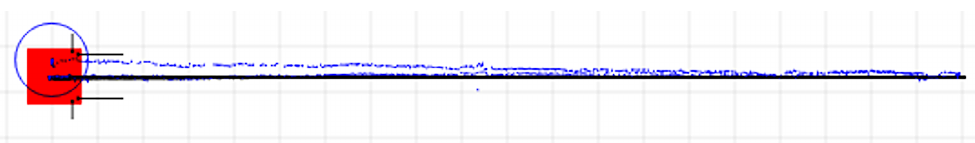
Figure 10. Two experiments for longitudinal translation correction factor determination by the IPS.